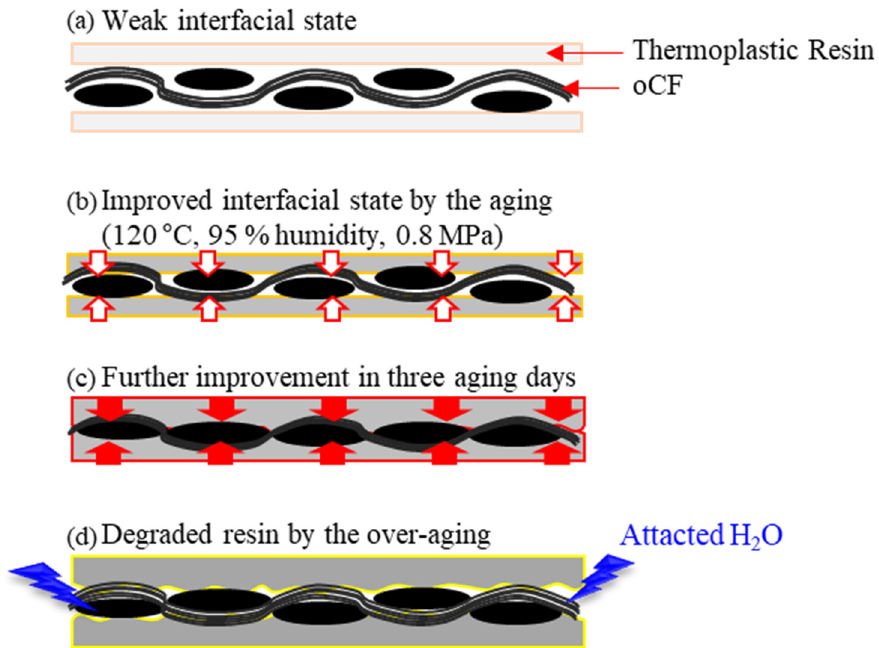
Figure 9. Schematic showing the interfacial properties of ( a ) as-prepared and ( b – d ) aged oCFOCs according to aging days.